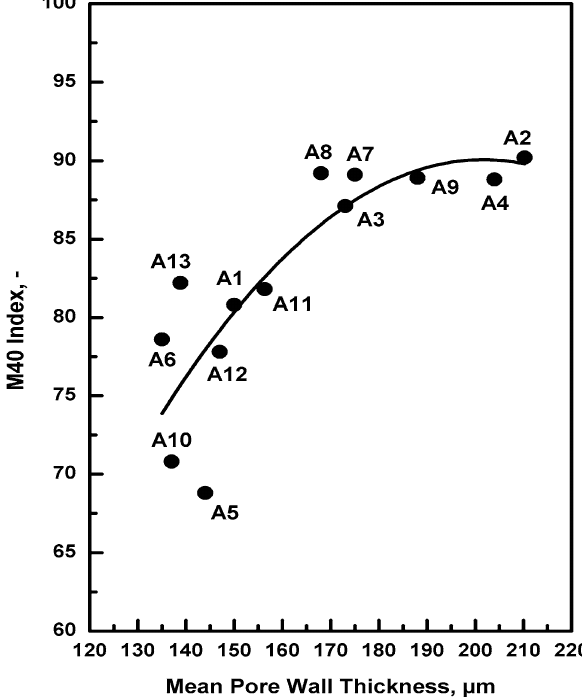
Fig. 4 Relationship between mean pore-wall thickness and M 40